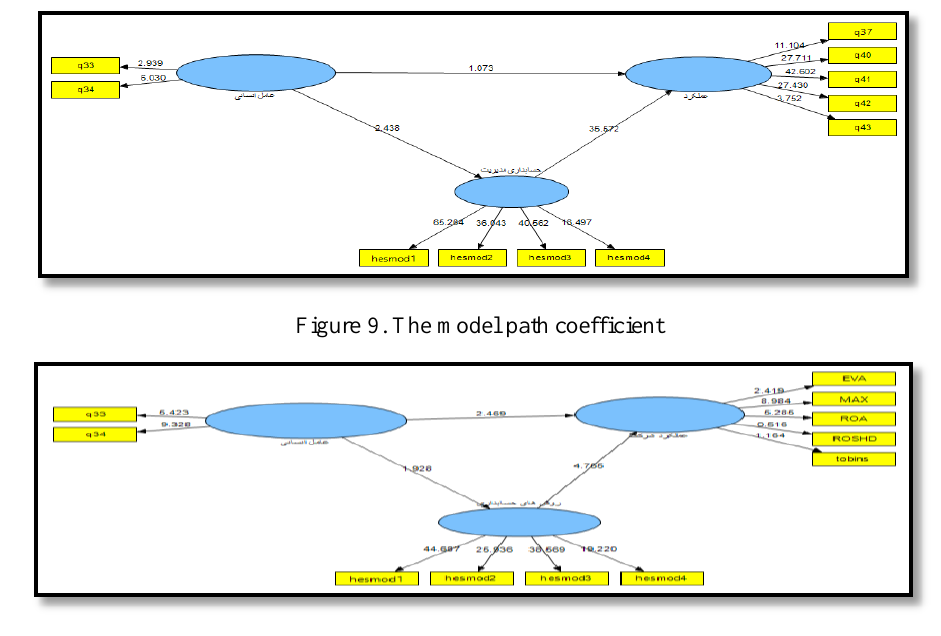
Figure 10. t-statistic for studying the significance of path